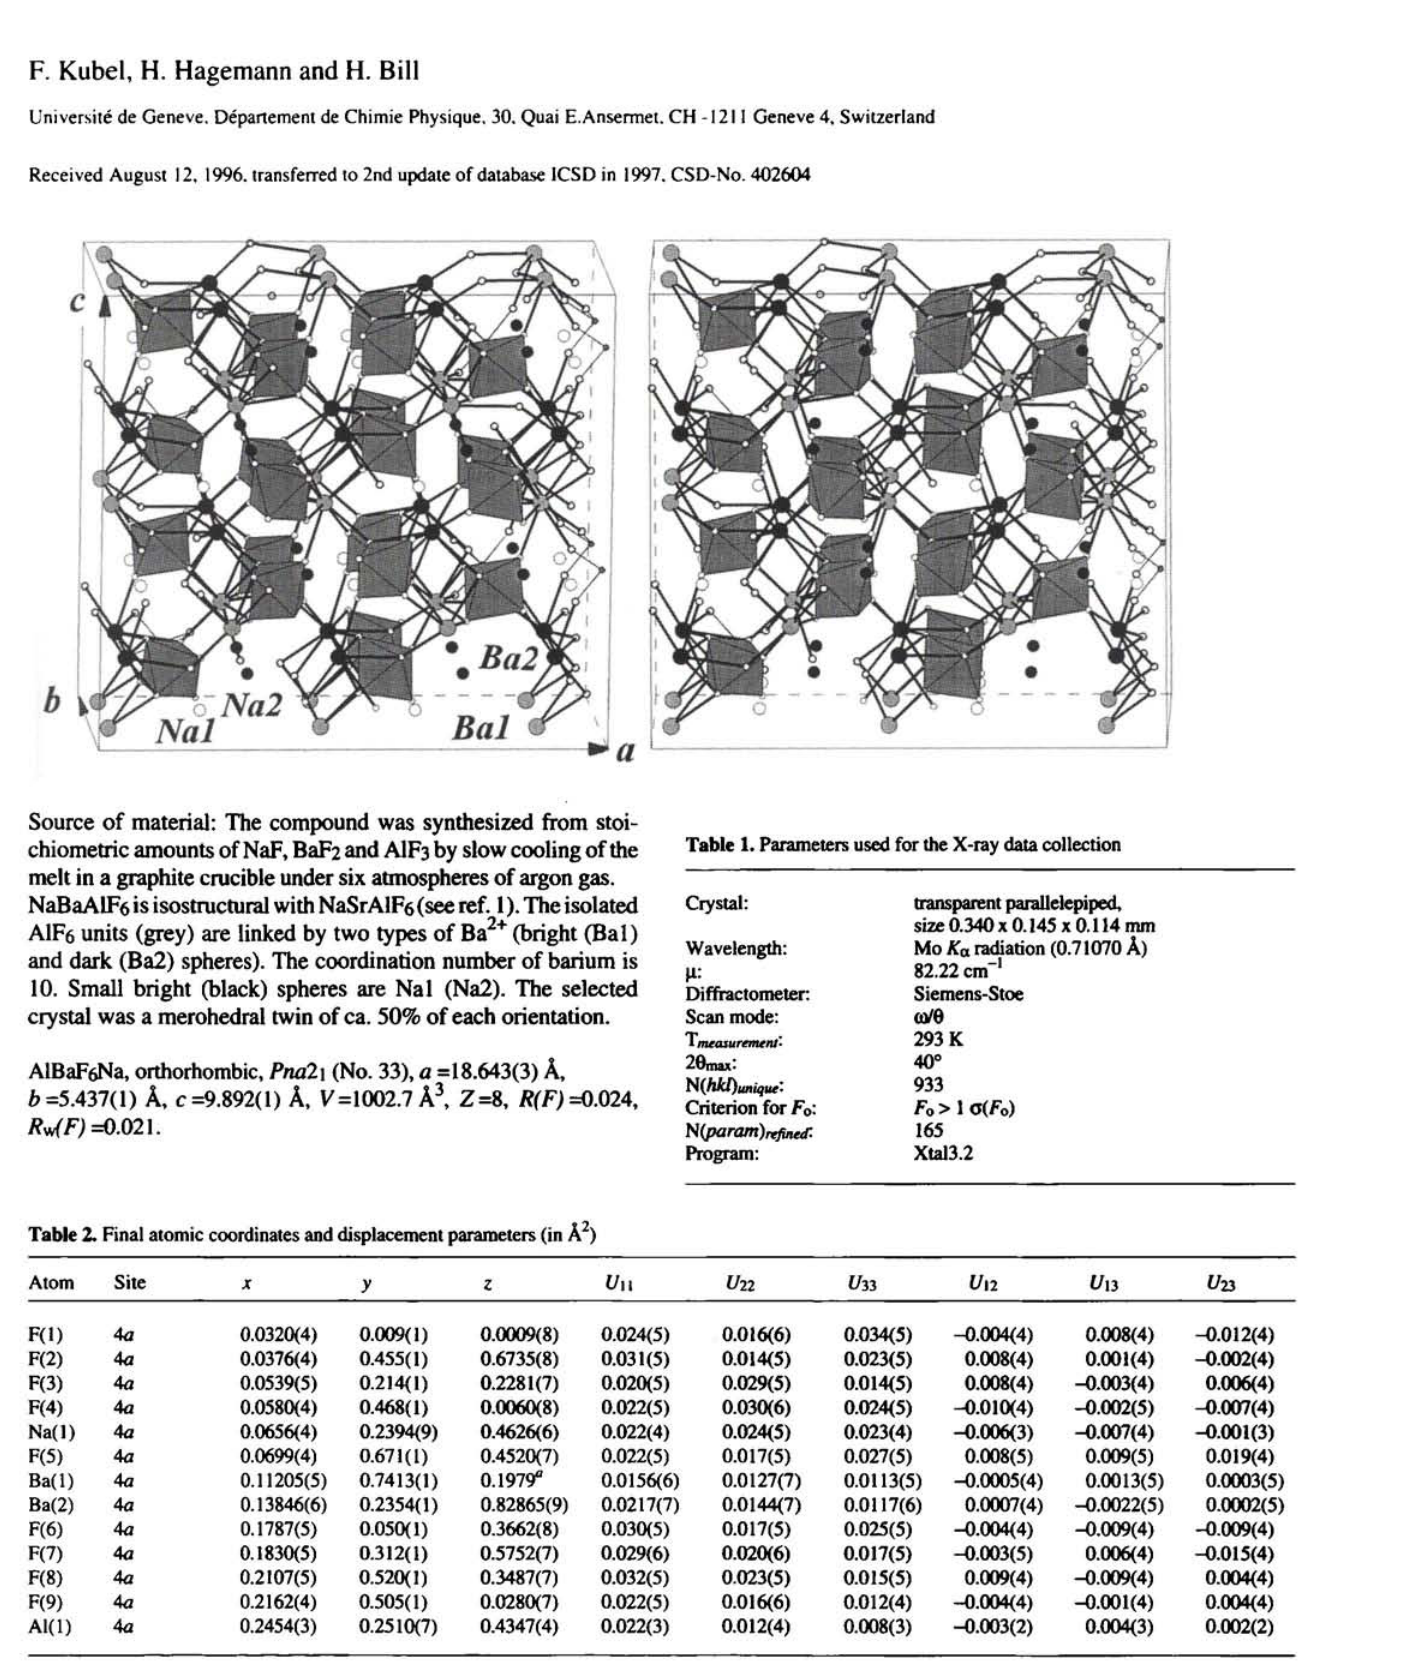
Table 2. Final atomic coordinates and displacement parameters (in Â 2